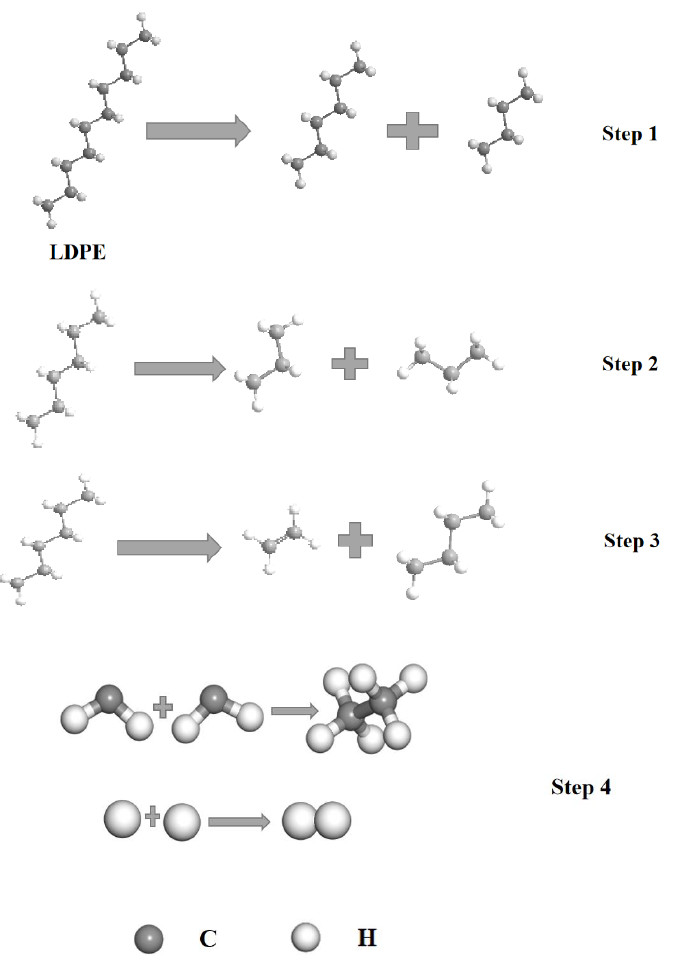
Figure 6. A plausible reaction pathway of LDPE pyrolysis without catalysts.